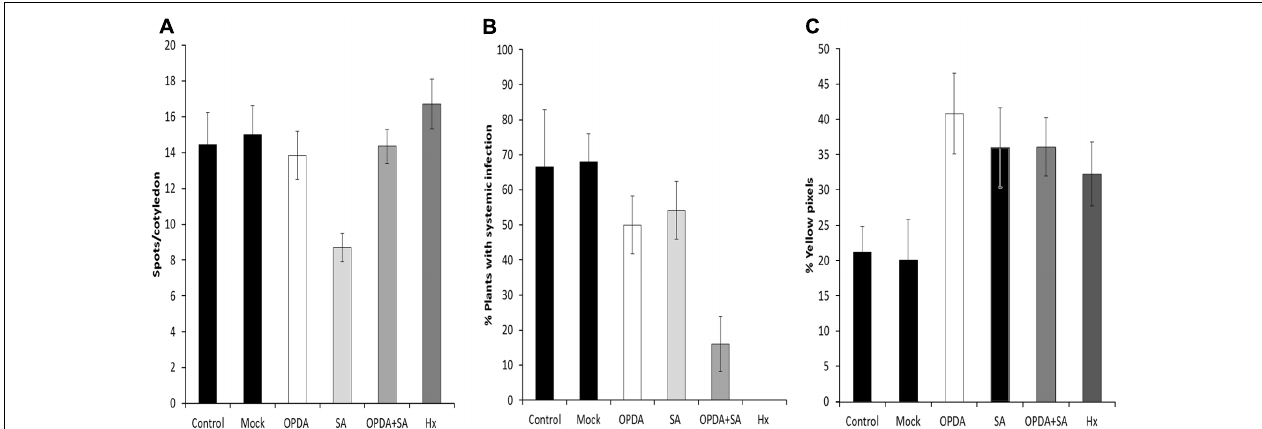
FIGURE 10 | Effect of the OPDA, SA and OPDA+SA treatments on MNSV infection and callose deposition. Infection severity was expressed as the number of spots per cotyledon at 5 dpi (A) and by counting the number of plants with systemic symptoms at 18 dpi (B) after OPDA, SA, OPDA+SA, and Hx treatments. Melon cotyledons were sampled at 5 dpi, stained with aniline blue and analyzed by epifluorescent microscopy. (C) Quantification was performed by determining the percent of yellow pixels in relation to the total pixels in the photographs. Data represent the mean ± SE of three independent experiments with 10 plants per